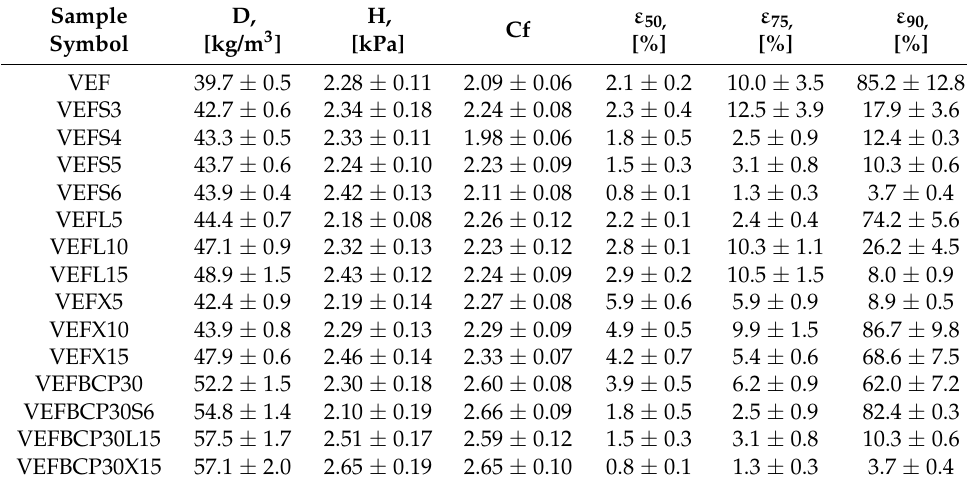
Table 7. Results of the analysis of apparent density and properties of foams determined during